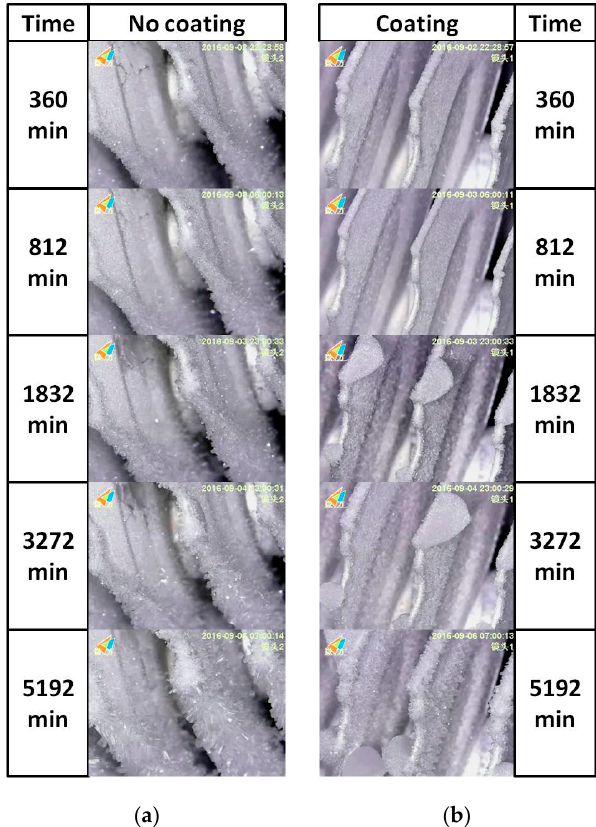
Figure 8. Frost formation process and variation of frost mass with time for various surfaces after defrosting. ( a ) normal surfaces; ( b ) PDMS-SiO 2 /SS hybrid coating surfaces.